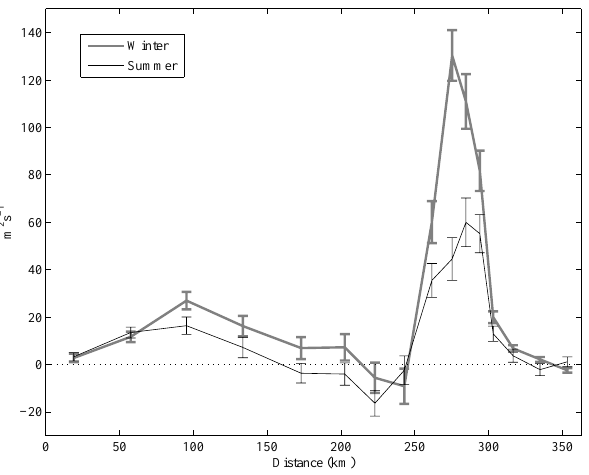
Fig. 5. Depth integrated velocity over the Atlantic water column in the Svinøy section, averaged for winter and summer, respectively.